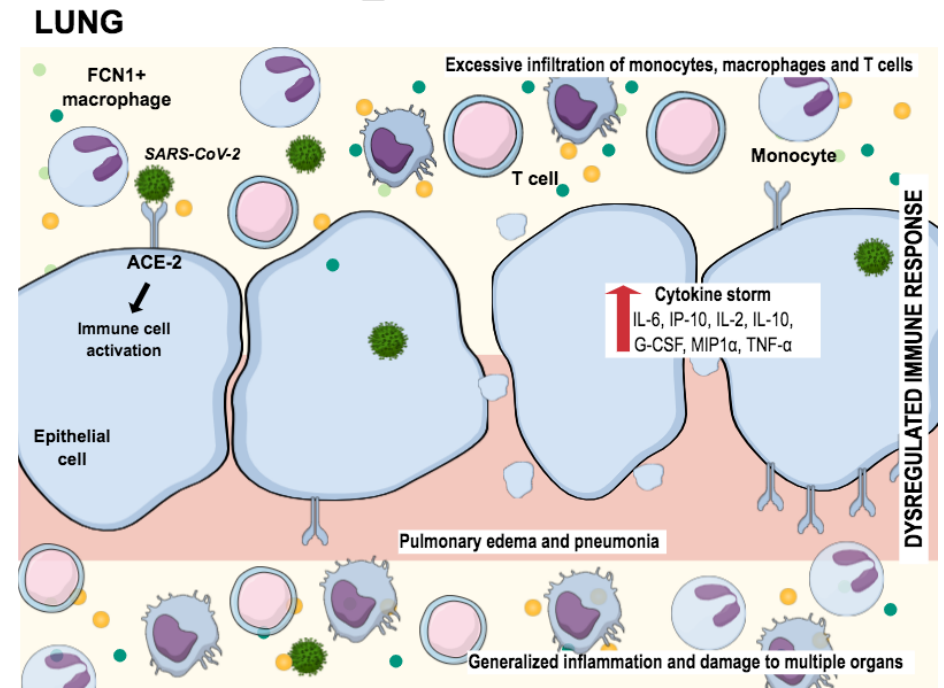
Figure 2. SARS-CoV-2 infecting cells in lung tissue through the interaction with angiotensin-converting enzyme 2 (ACE2), promoting the generation of pro-inflammatory cytokines (cytokine storm). This process attracts “defense” cells such as macrophages, monocytes, and T cells to the site of infection, triggering the inflammation process. The result of this inflammation is lung tissue damage. Adapted from Tay et al., 2020 [102].